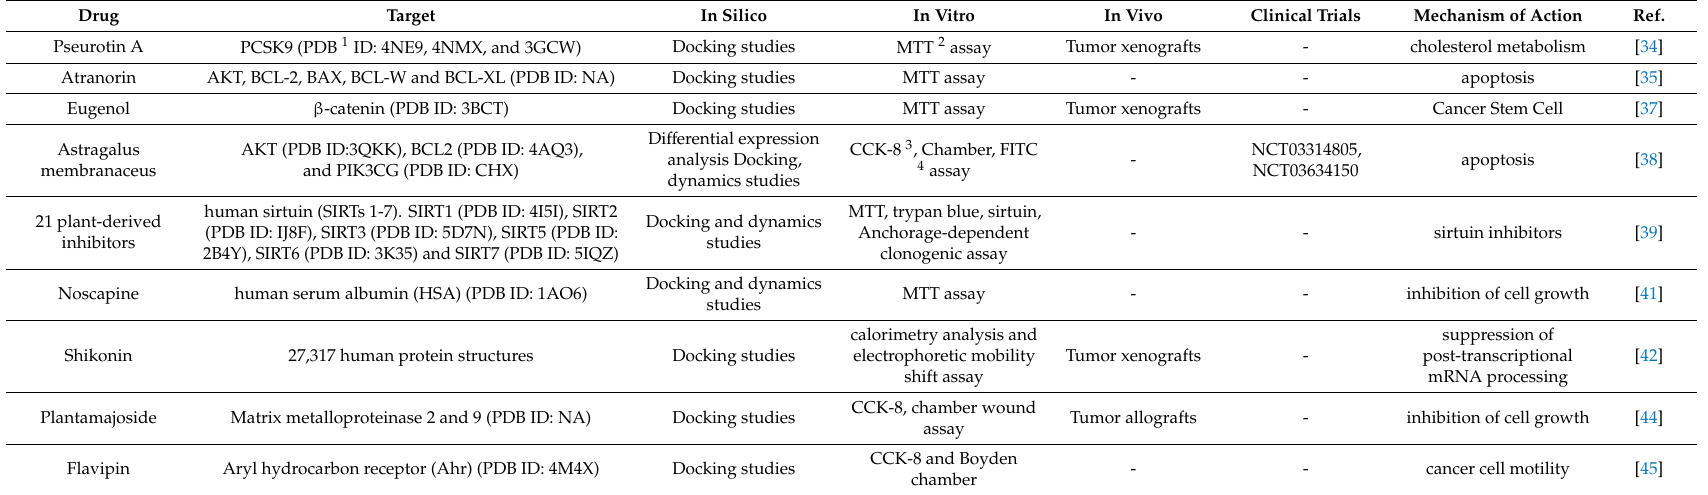
Table 2. Characteristics of the studies reported herein categorized as "natural drugs" used in metastatic breast cancer. The table reports the drug, its target with PDB ID, the in silico / in vitro / in vivo methods used to test the drug, clinical trials, the mechanism of action, and the reference. Drug Target In Silico In